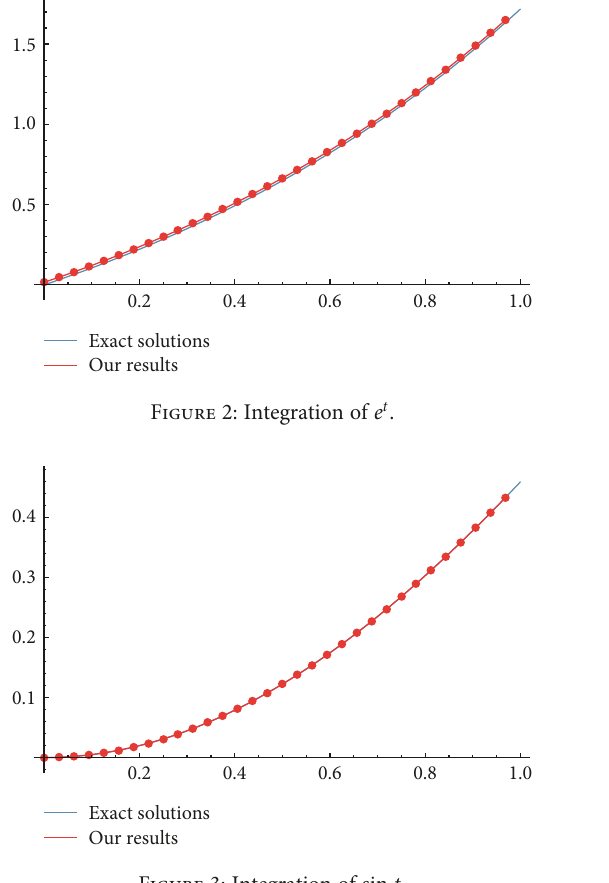
Figure 3: Integration of sin t